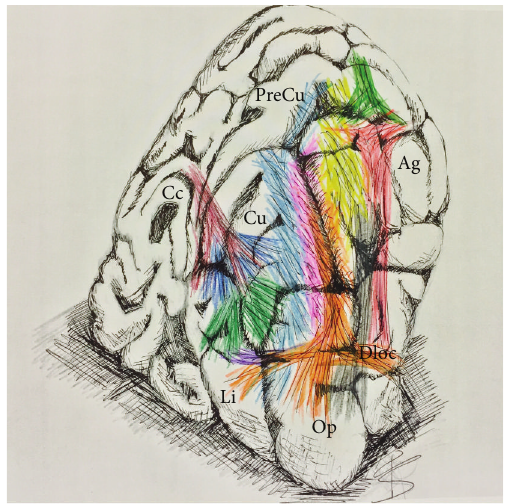
Figure 5: Artistic illustration of the white matter connectivity underlying the occipital region. The illustration shows a schematic reconstruction from a posterior coronal view the occipital region with all the major white matter bundles dissected and shown with different colours through the cortical layer. This illustration serves to summarize the complex subcortical organization, which can be significantly correlated to the semiology of the seizures involving each sublobar occipital region. A lesion on the lateral surface of the occipital lobe or at the temporo-occipital/parieto-occipital junction would probably spread to the parietal and frontal regions. The ver- tical component of the superior longitudinal fasciculus (vSLF/red), arcuate fasciculus or the horizontal superior longitudinal fasciculus (AF/yellow, hSLF/light green), and the vertical occipital fasciculus (VO/gray) can support this direction of propagation. Deep lesions may involve different pathways within the sagittal stratum of Sachs (SSS) such as inferior longitudinal fasciculus (ILF/orange), middle longitudinal fasciculus (MLF/pink), inferior fronto-occipital fasci- culus(IFOF/lightblue),oreventheopticradiation(OR/darkgreen). According to the hierarchical segregation of the fibres, the epileptic propagation would spread to temporo-lateral areas, temporo-mesial areas, and/or frontal lobe. Moreover, a possible epileptic lesion in a dorsal-mesial location with respect to the OR and calcarine fissure would involve fibres of the cingulum (Ci/dark red) and callosal fibres of the forceps major-tapetum (Ta/dark blue) with a resultant ipsilateral and/or contralateral epileptic propagation. Finally, ventral-mesial deep lesions located below the calcarine fissure can involve the ventral portion of the IFOF (light blue) with a fast propagation to the frontal lobe or can recruit the ventral portion of the ILF (orange) and Li-Am bundle (LiAm/purple) with a fast temporo-mesial involvement (see the text for the functional considerations). Ag: angular gyrus; Cc: corpus callosum; Cu: